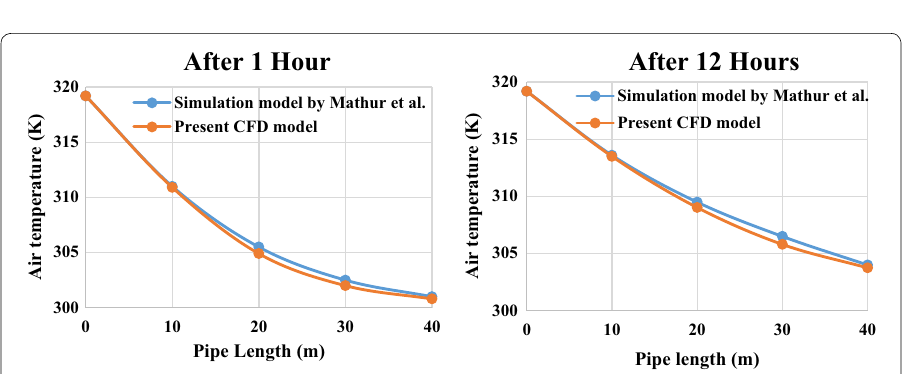
Fig. 4 Comparison between published CFD model and present CFD